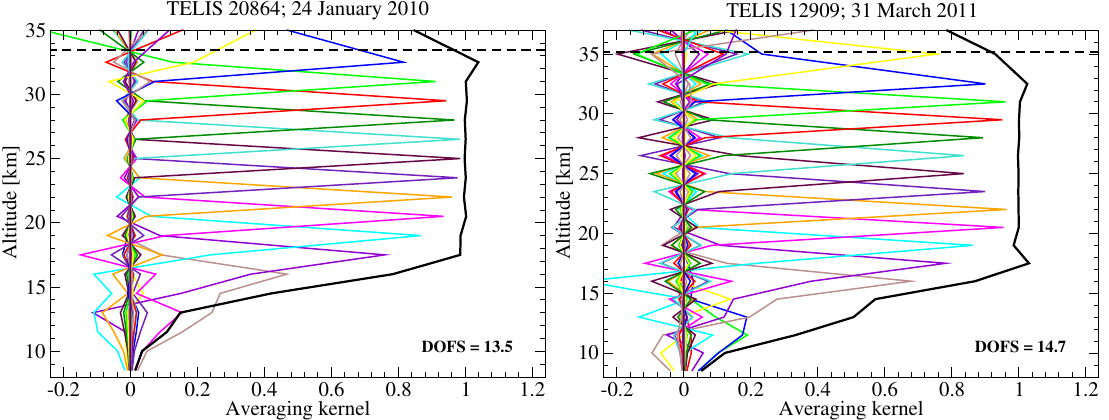
Figure 13. Averaging kernels and DOFS for the CO retrievals from TELIS FIR measurements 20864 (24 January 2010) and 12909 (31 March 2011), respectively.